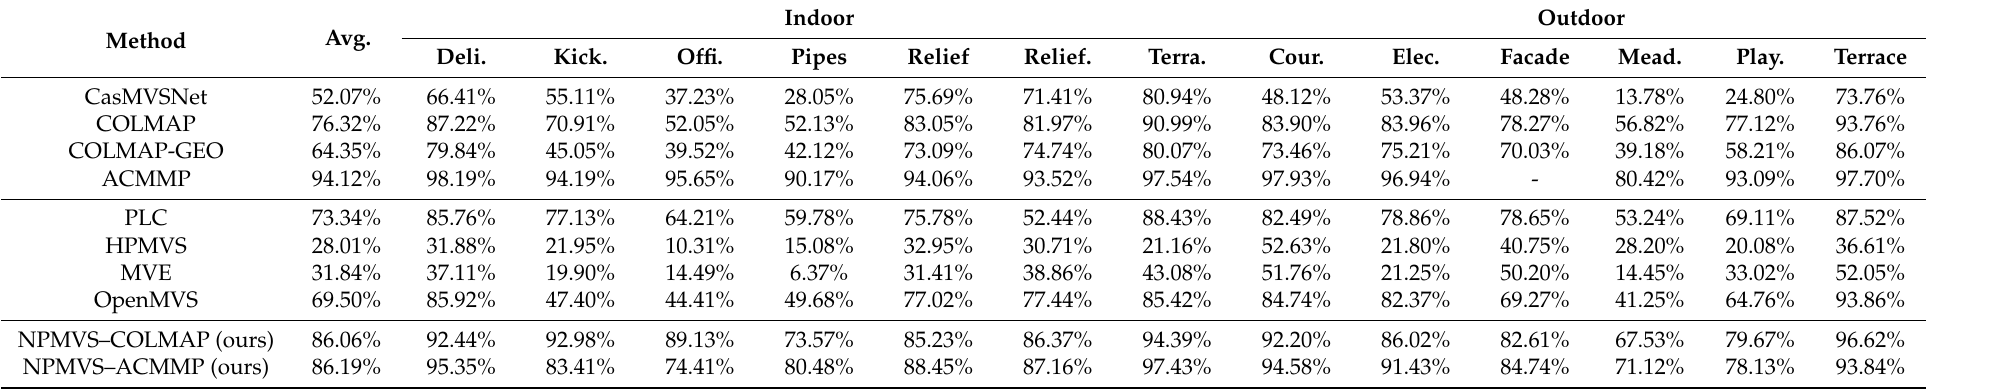
Table 3. Comparison of completeness (higher is better).